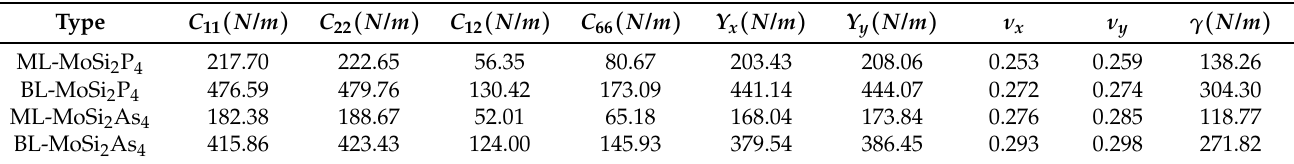
Figure 3. ( a ) Phonon band dispersion curves of the monolayer MoSi 2 As 4 . Variations of total energy at 300 K as functions of time for ( b ) monolayer MoSi 2 As 4 , ( c ) bilayer MoSi 2 P 4 , ( d ) bilayer MoSi 2 As 4 . ( e ) Young’s modulus Y ( θ ) and ( f ) Poisson’s ratio ν ( θ ) of bilayer MoSi 2 P 4 (purple curve) and MoSi 2 As 4 (blue curve) along arbitrary in-plane directions. Table 2. The calculated elastic constants C ij , Young’s modulus Y and Poisson’s ratio ν along the x ( θ = 0) and y ( θ = π /2) directions, layer modulus γ for monolayer (ML-) and bilayer (BL-) MoSi 2 Z 4 (Z = P,